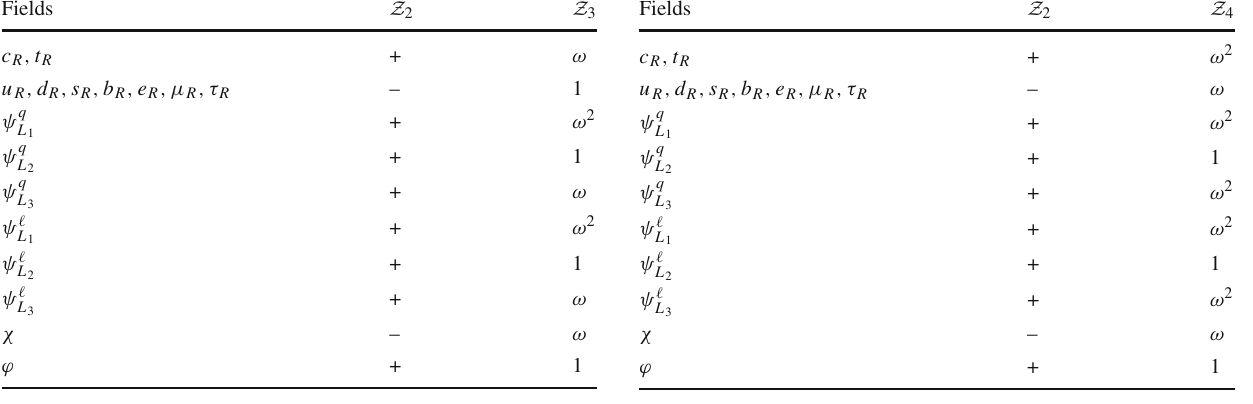
Table3 Thechargesofleftandright-handedfermionsofthreefamilies of the SM, Higgs and the flavon fields under the Z 2 and Z 4 product symmetry, where ω is the fourth root of unity Fields